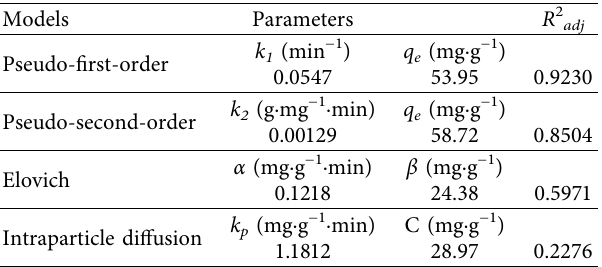
Table 1: Kinetic models of adsorption of Cr (VI) onto Cu (I)-MOF in aqueous